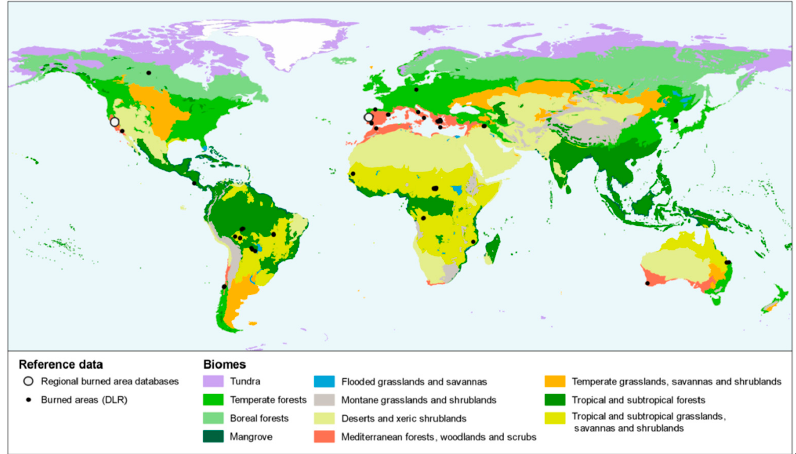
Figure 1. Sample locations of the reference dataset used for training, validation and testing of the proposed burned area segmentation method, overlaid on a global biomes map adapted from [52].